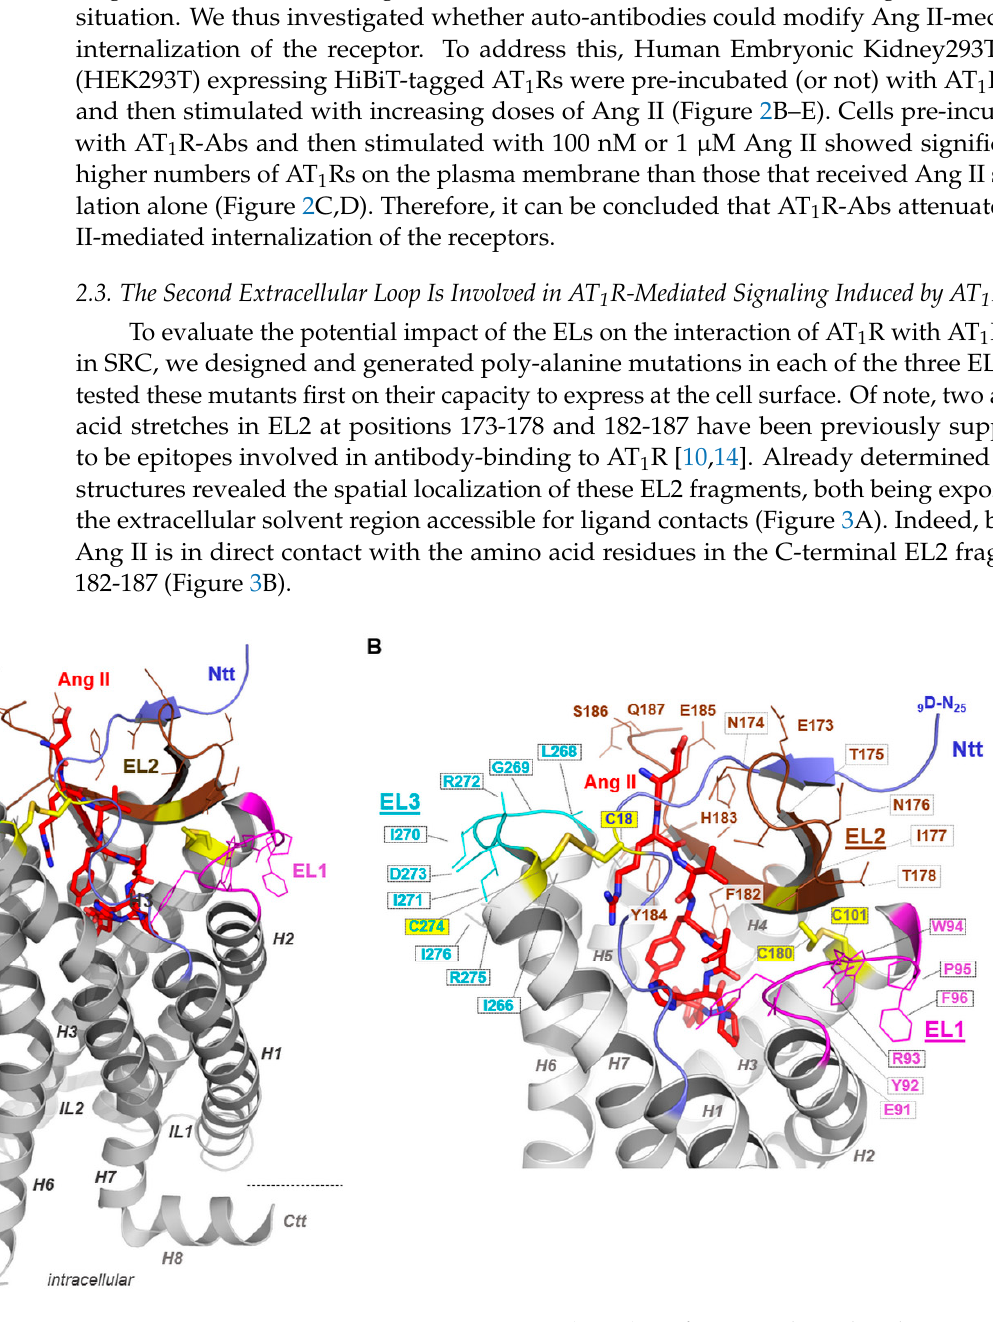
Figure 3. Active Angiotensin II type 1 receptor (AT 1 R) conformation bound with angiotensin II